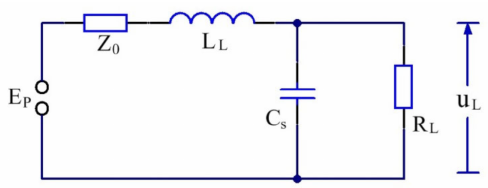
Figure 14. Equivalent circuit of the pulse modulator at the time of the pulse front edge [26], where E p is the discharge voltage of energy storage element, Z 0 is the impedance of energy storage element, L L is the excitation inductance of pulse transformer, C s is the distributed capacitance of pulse transformer, and R L is the equivalent impedance of the pulse